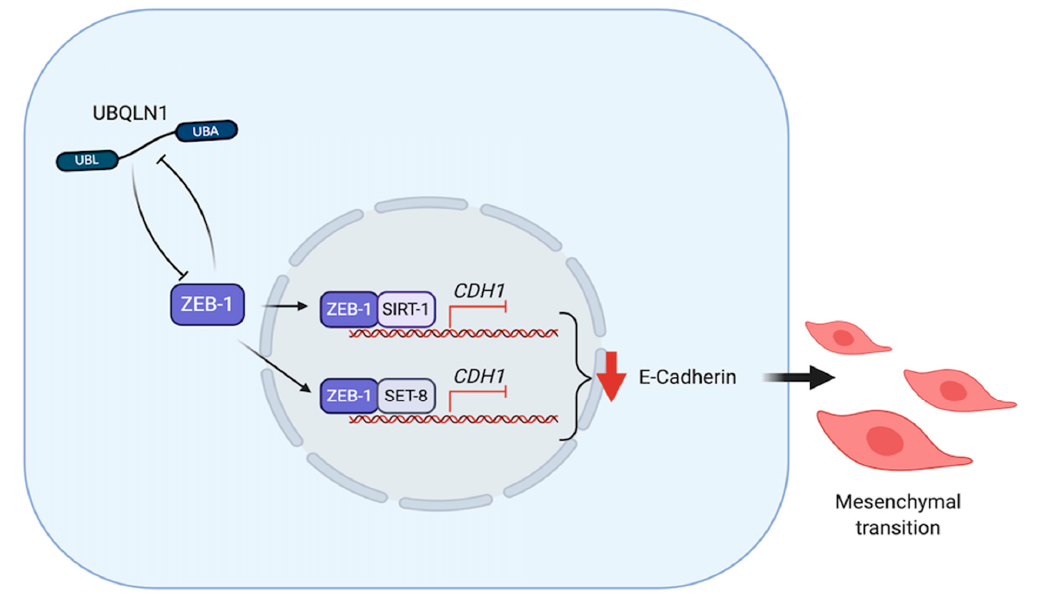
Figure 5. UBQLNs and ZEB1 networking in cancers. UBQLN1 and ZEB1 negatively regulate each other. UBQLN1 can repress E-cadherin expression via ZEB-1 dependent mechanism. ZEB1 forms